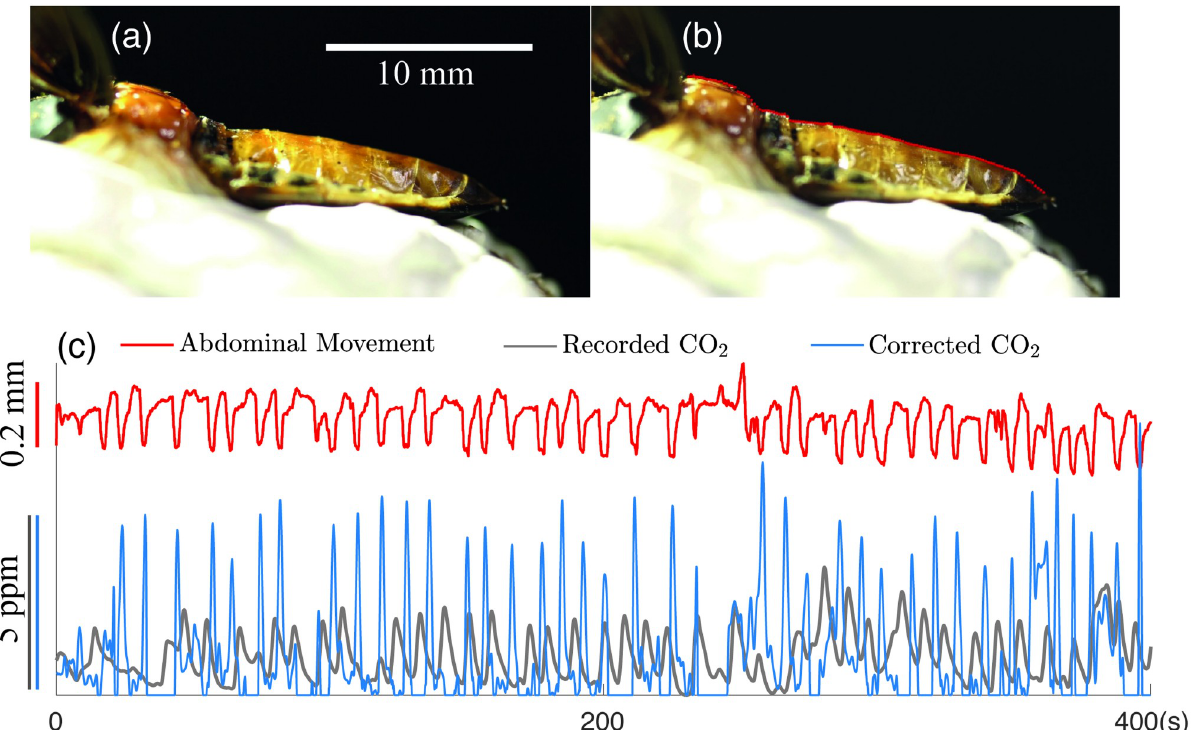
Fig 13. Experimental results for nonlinear case study. In this experiment, abdominal pumping and CO 2 emission of a breathing insect are recorded and synchronized. (a) A darkling beetle is breathing in the respirometry chamber. (b) Abdominal movements of a darkling beetle (red dots) are recorded. (c) The abdominal movement (red) signal samples. The recorded CO 2 emission samples (grey) from the chamber. The reconstructed CO 2 signals (blue) with Algorithm 2 from a flat initial guess of the impulse response function, delay of 21.3 sec, and support of 18.4 sec. The recovered CO 2 signal is concurrent with the abdominal movement of the